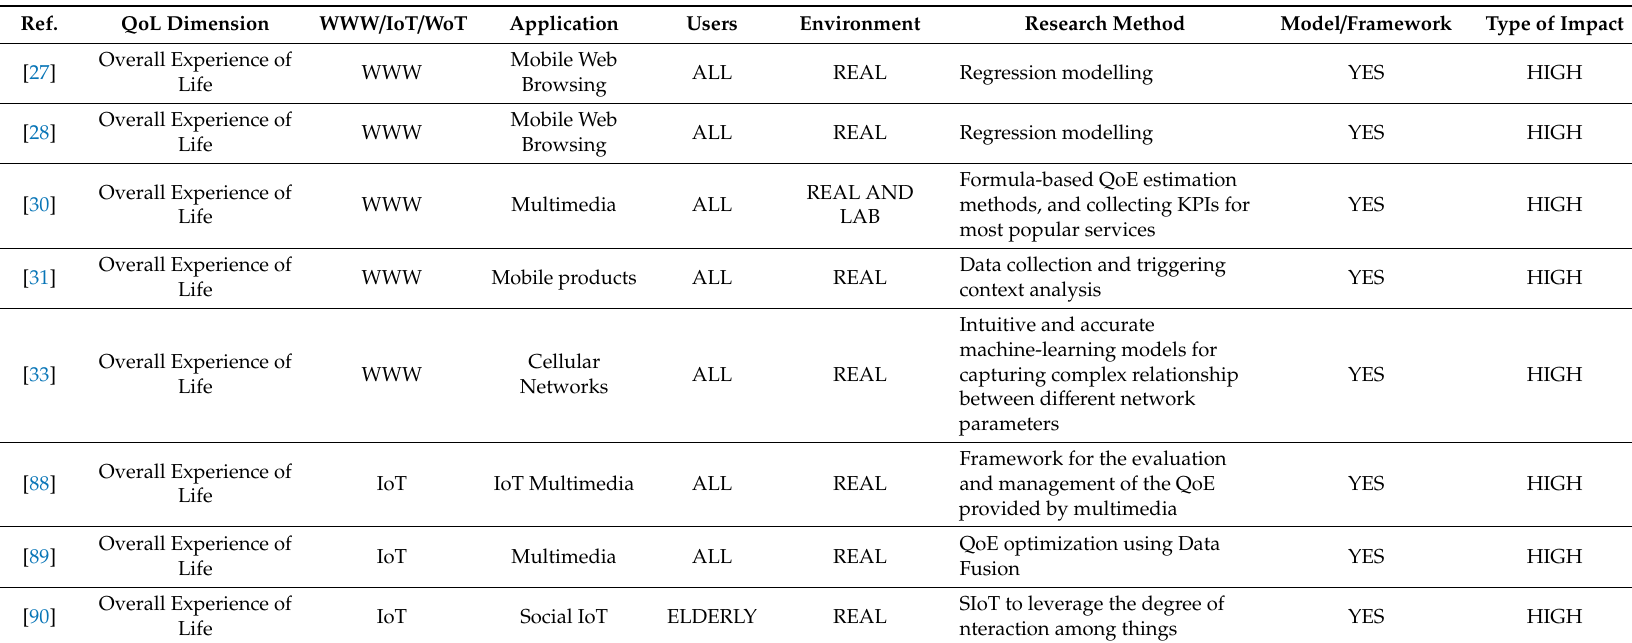
Table A1. The influence of QoE on QoL and its